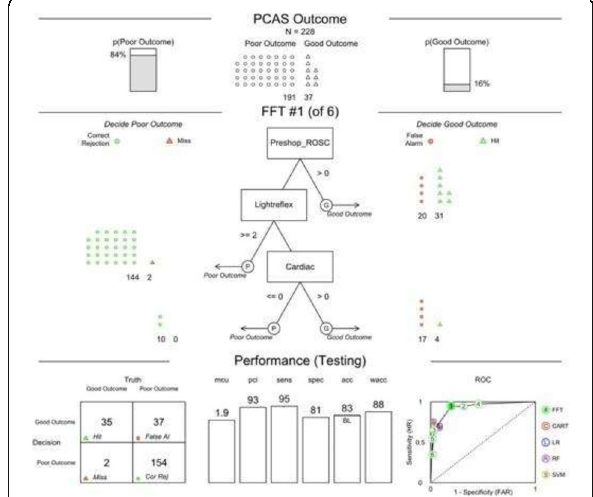
Fig. 3 (abstract 0307). Visualization of cue accuracies shown by the plot (what=''cues'', data=''train'')